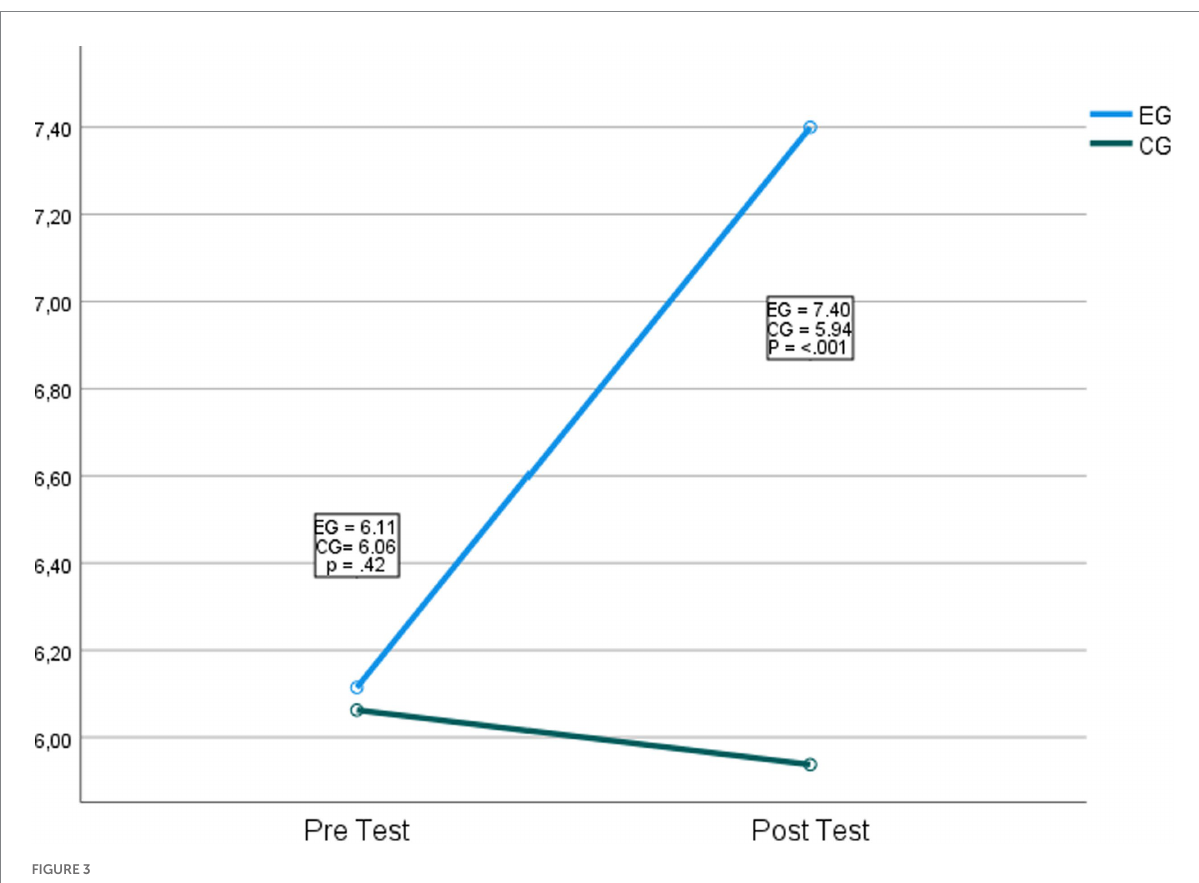
FIGURE 3 Comparison of the control and experimental groups in